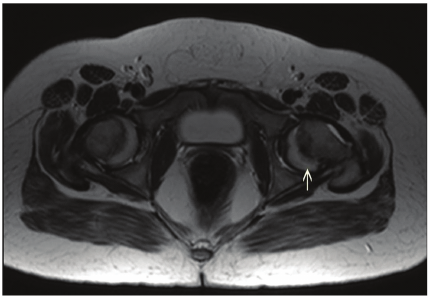
Figure 1: Axial T2-weighted MR image at the level of bilateral hip joint showing posterior displacement of the epiphysis of femoral head on left side (arrow).